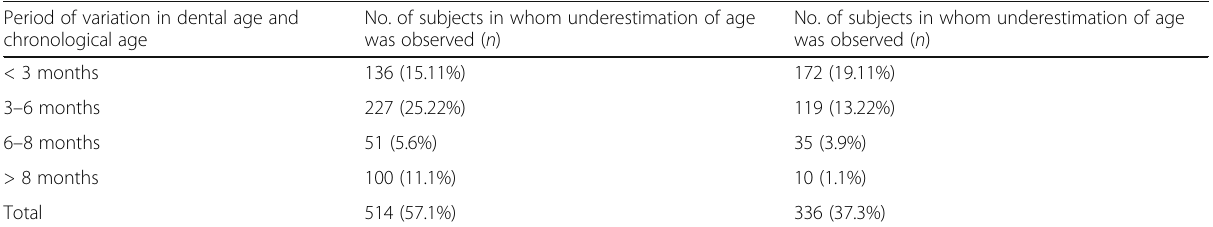
Table 3 Incremental pattern to understand the pattern of underestimation and overestimation in development amongst our subjects Period of variation in dental age and chronological age